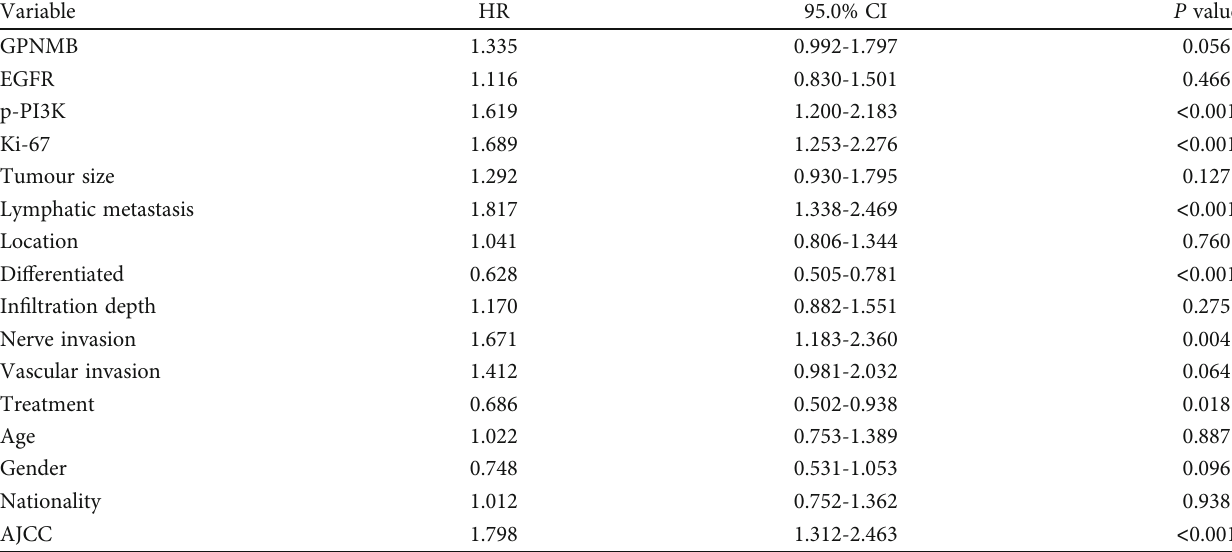
Table 2: Univariate analysis of factors associated with OS in ESCC patients.